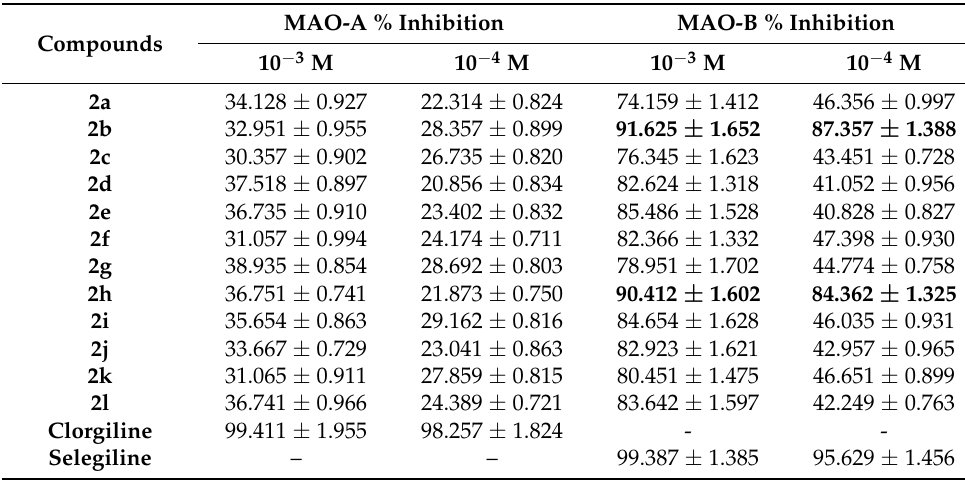
Table 1. % Inhibition of compounds 2a – 2l against MAO-A and